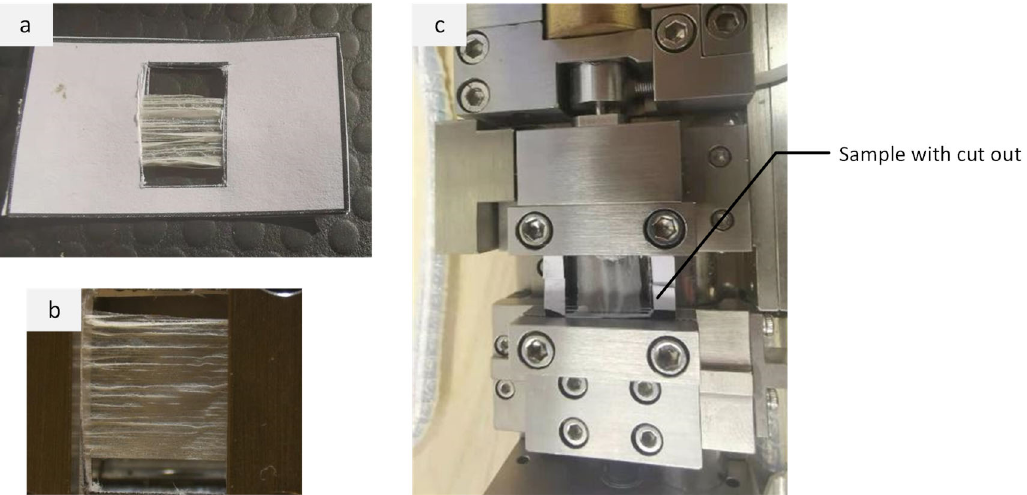
Figure 4. ( a ) Electrospun sample sandwiched between the rectangular plates 10mm wide, ( b ) close-up view of the sample, and ( c ) sample placed between the upper and lower jaws of the tensile equipment.